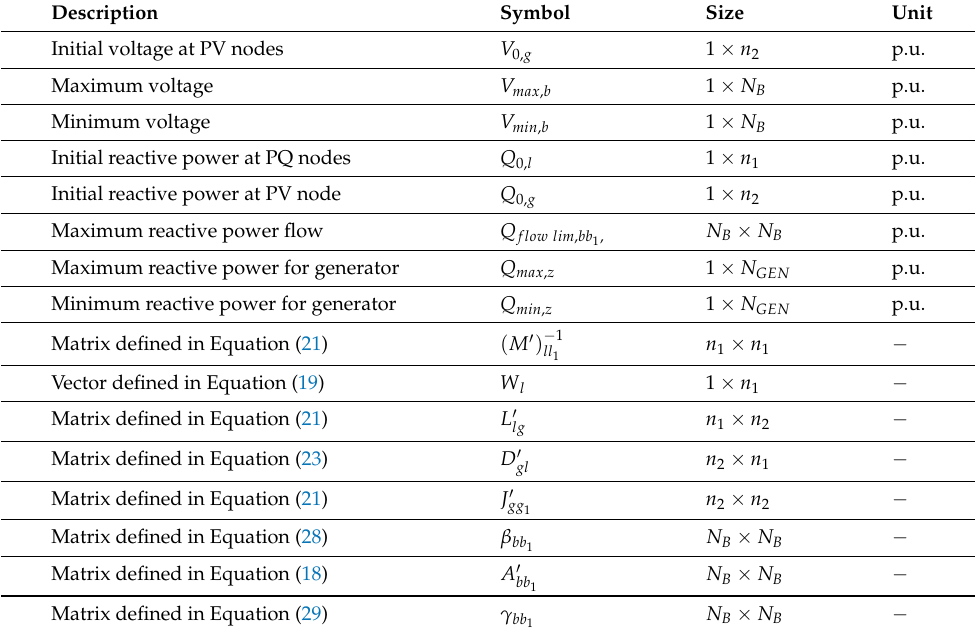
Table 3. Parameters for the optimal Volt/Var control algorithm.